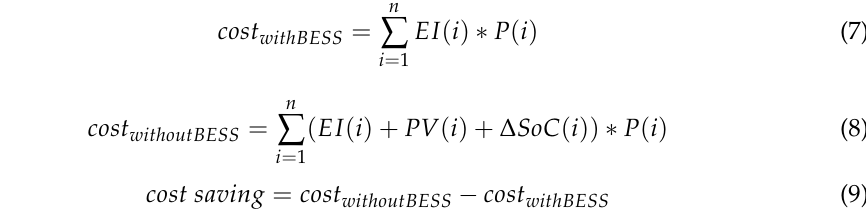
Figure 9. The operation of the BESS ( PV output is dominant). When the consumption of the swimming pool is lower than the PV generation, the decision-making and optimisation algorithm will charge the battery even if the price is high.